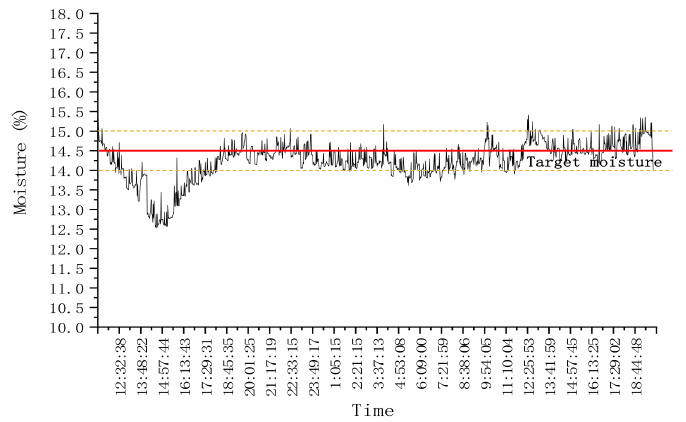
Figure 13. Variation of outlet moisture with intermittent time in the drying